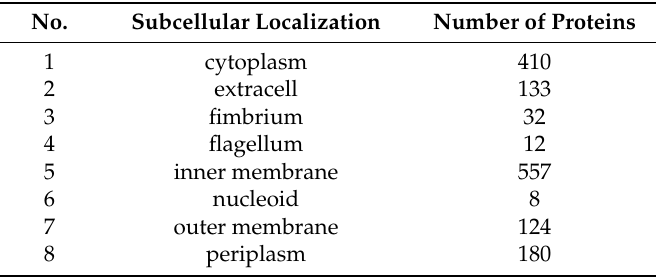
Table 7. The name and the size of each location for the Gram-negative data set. No. Subcellular Localization Number of Proteins 1 cytoplasm 410 2 extracell 133 3 fimbrium 32 4 flagellum 12 5 inner membrane 557 6 nucleoid outer membrane 124 8 periplasm